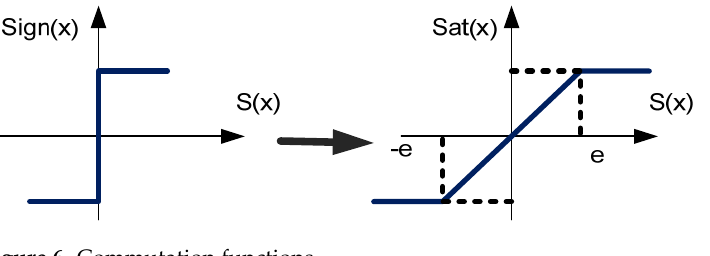
Figure 5. SM − PI flux and torque regulation.